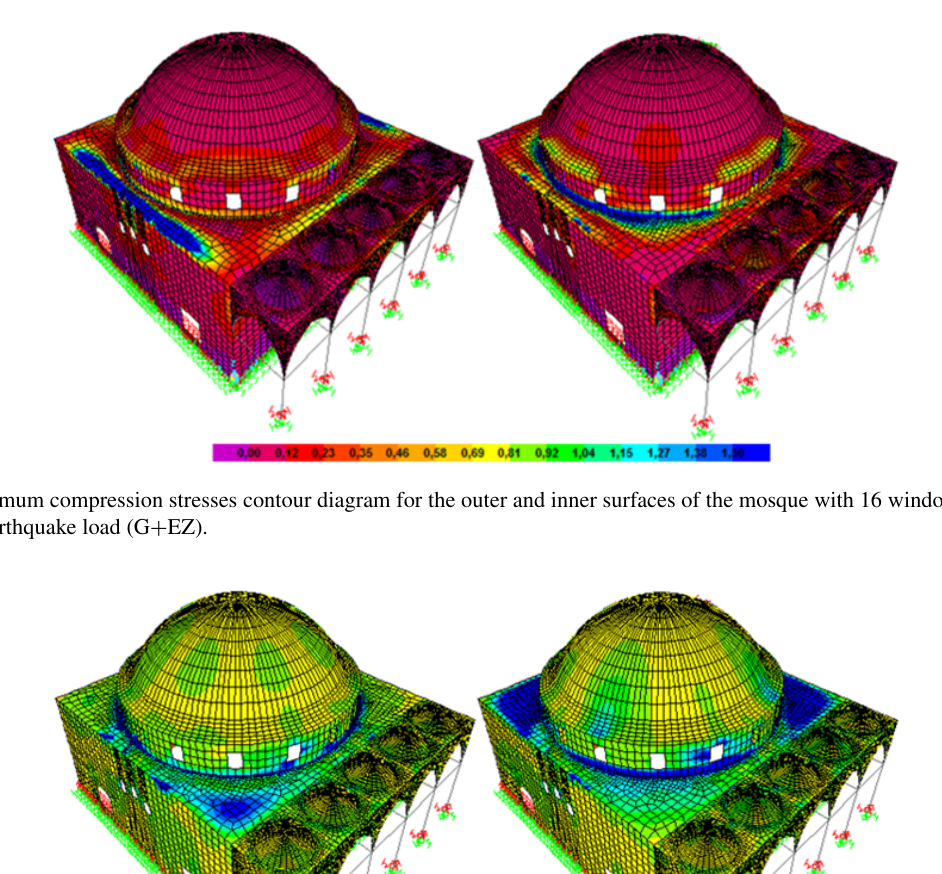
Figure 14. Maximum tensile stresses contour diagram for the outer and inner surfaces of the mosque with 16 window openings under dead load and earthquake load (G + EZ).